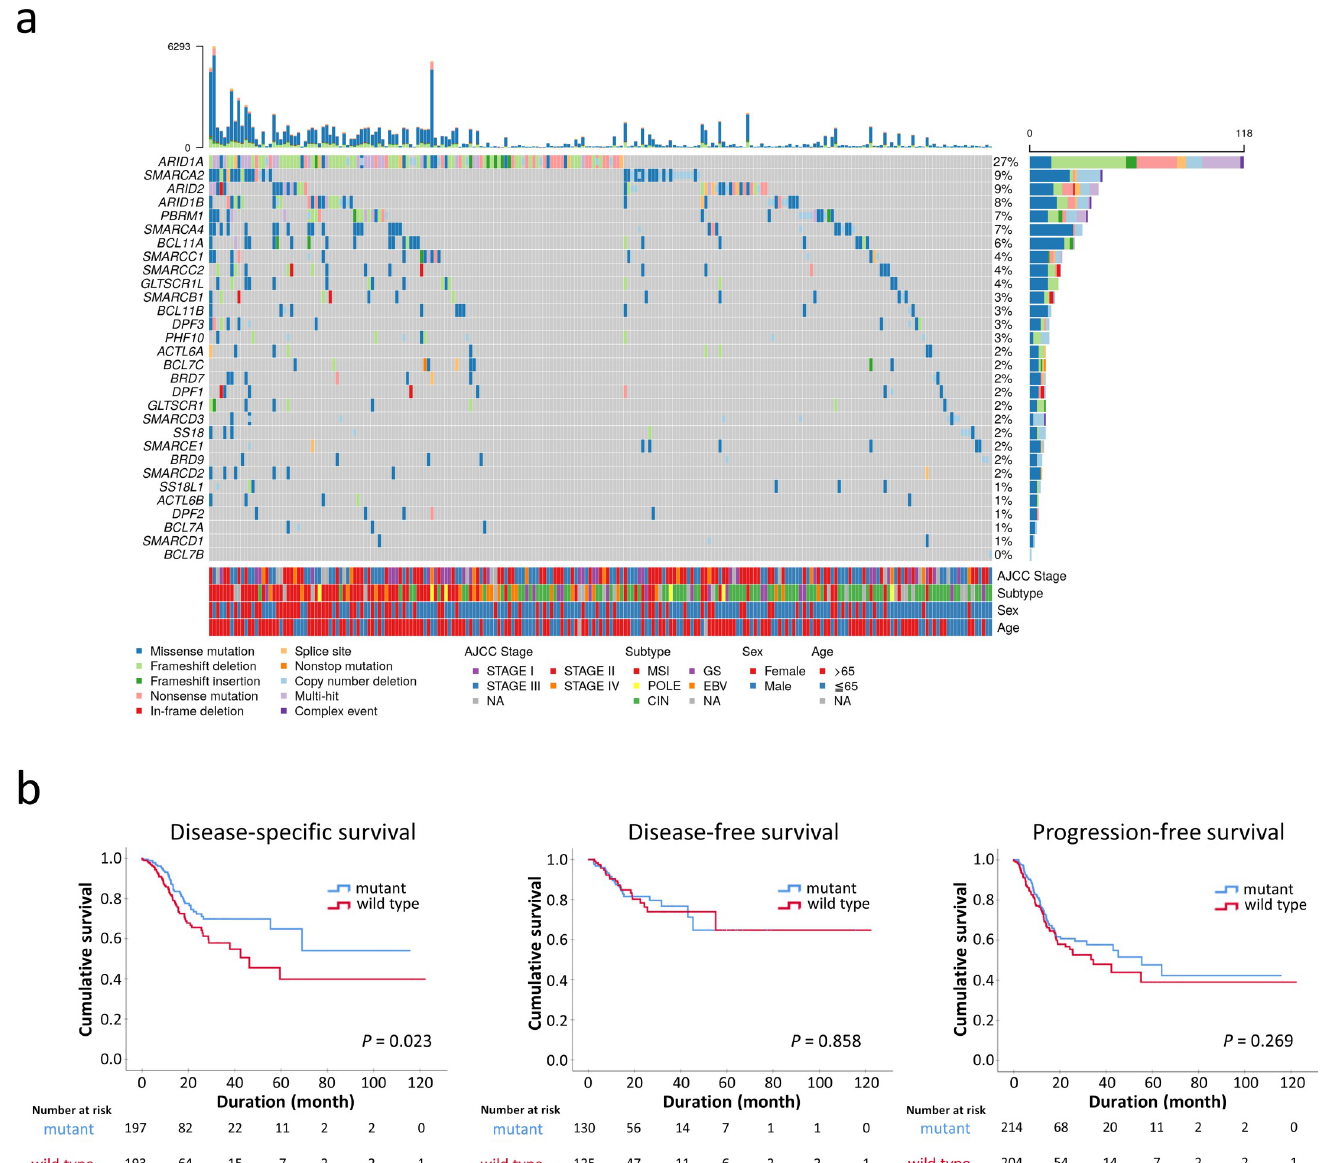
Fig 4. a. The oncoplot showing the landscape of SWI/SNF mutations in 434 STAD patients from the TCGA Pan-Cancer Atlas. Synchronous multiple SWI/SNF mutations were common, especially in the microsatellite-instable genotype. The upper part represents the mutation burden of each patient. NA, not available. b. SWI/SNF-mutated gastric cancer exhibits an association with improved disease-specific survival ( P = 0.023) but had no significant prognostic difference in disease- free or progression-free survival.